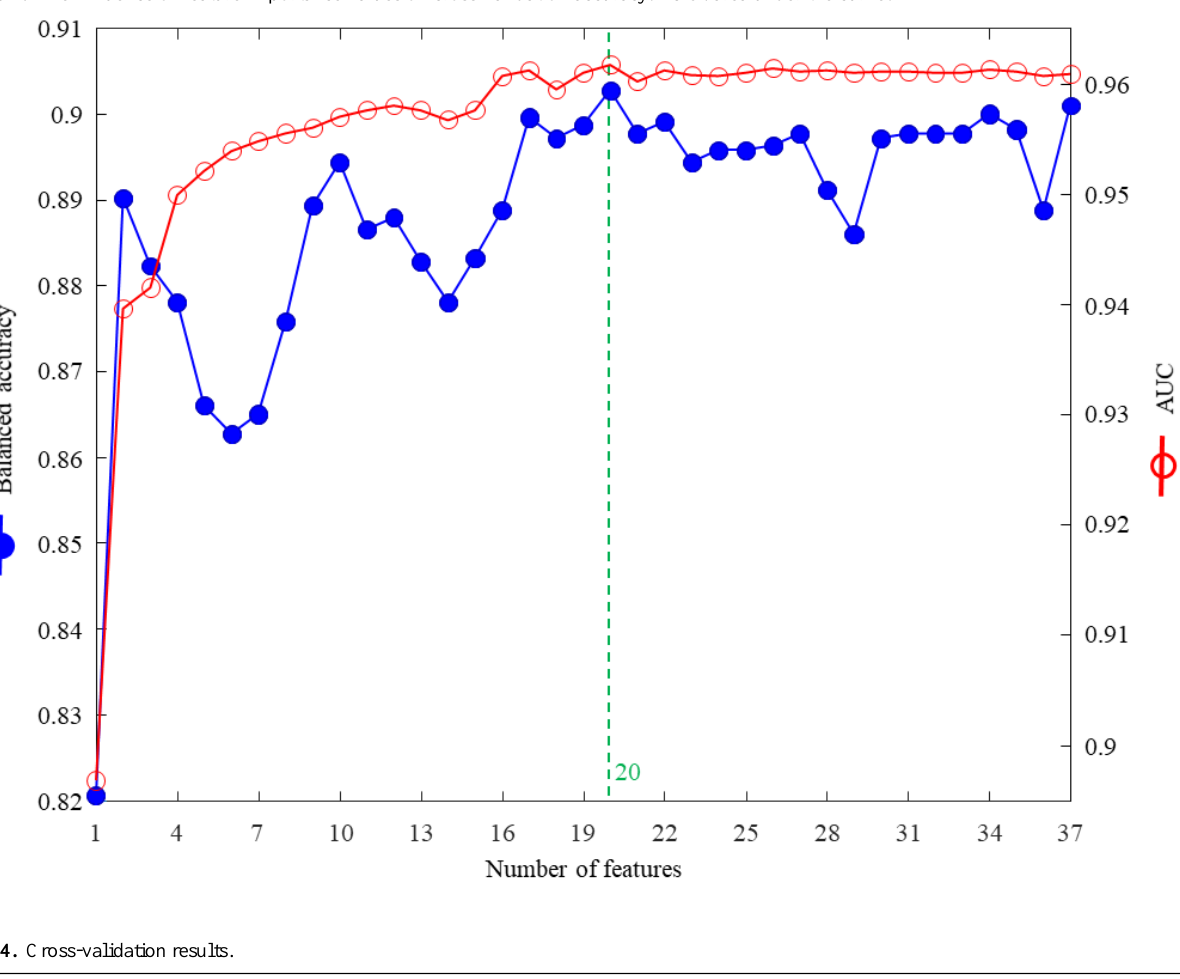
Cross-validation measures (n=448), mean